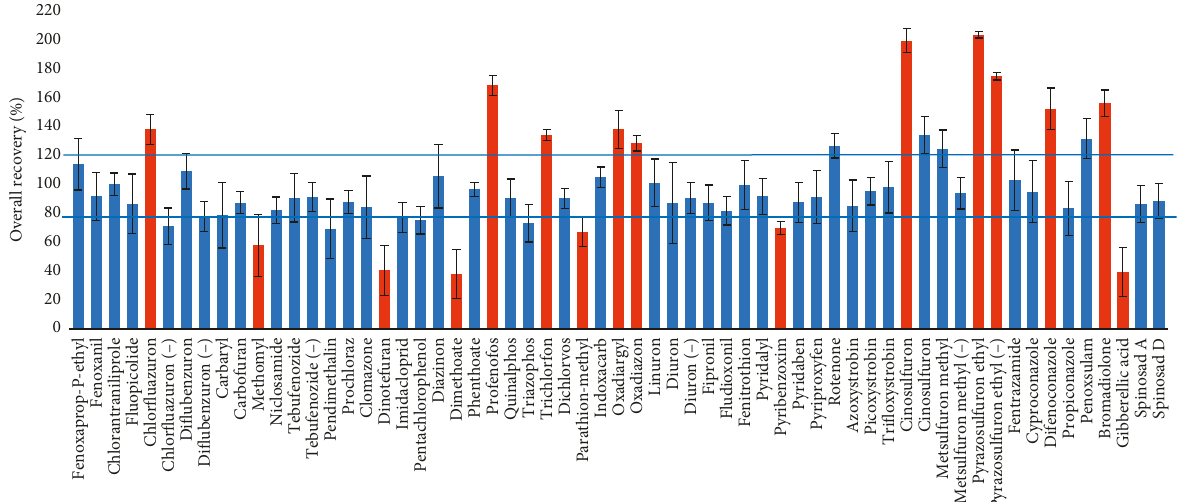
Figure 4: Overall recovery of all targeted analytes in pooled samples analyzed by UPLC-Orbitrap MS. Columns and error bars present the overall recovery and relative standard deviation ( n � 3), respectively. Red color indicates the recovery of the analyte out of an acceptable range (from 80 to 120%). ( − ) denotes an analyte that is measured in the negative electrospray ionization mode.